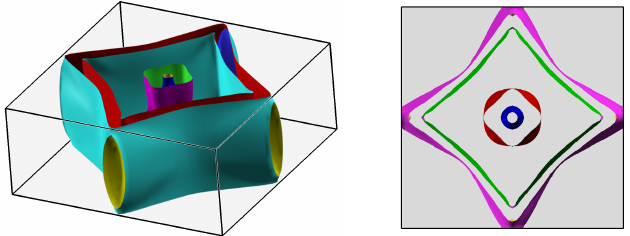
Figure 5. Three-dimensional and top view ( left and right panels, respectively) of the Fermi surface of LaAgSb 2 in the absence of the spin–orbit